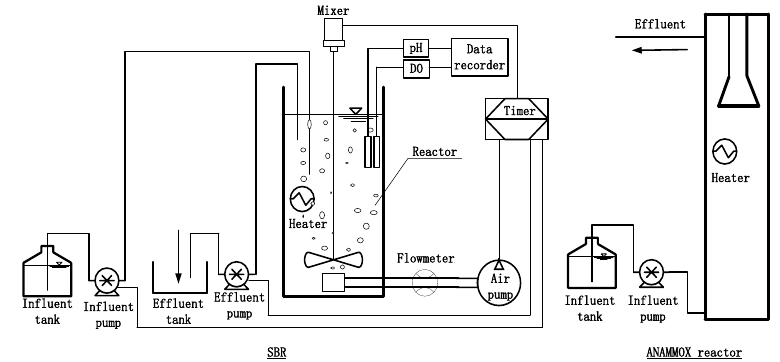
Figure 1. Schematic diagram of SBRs and ANAMMOX reactor systems.